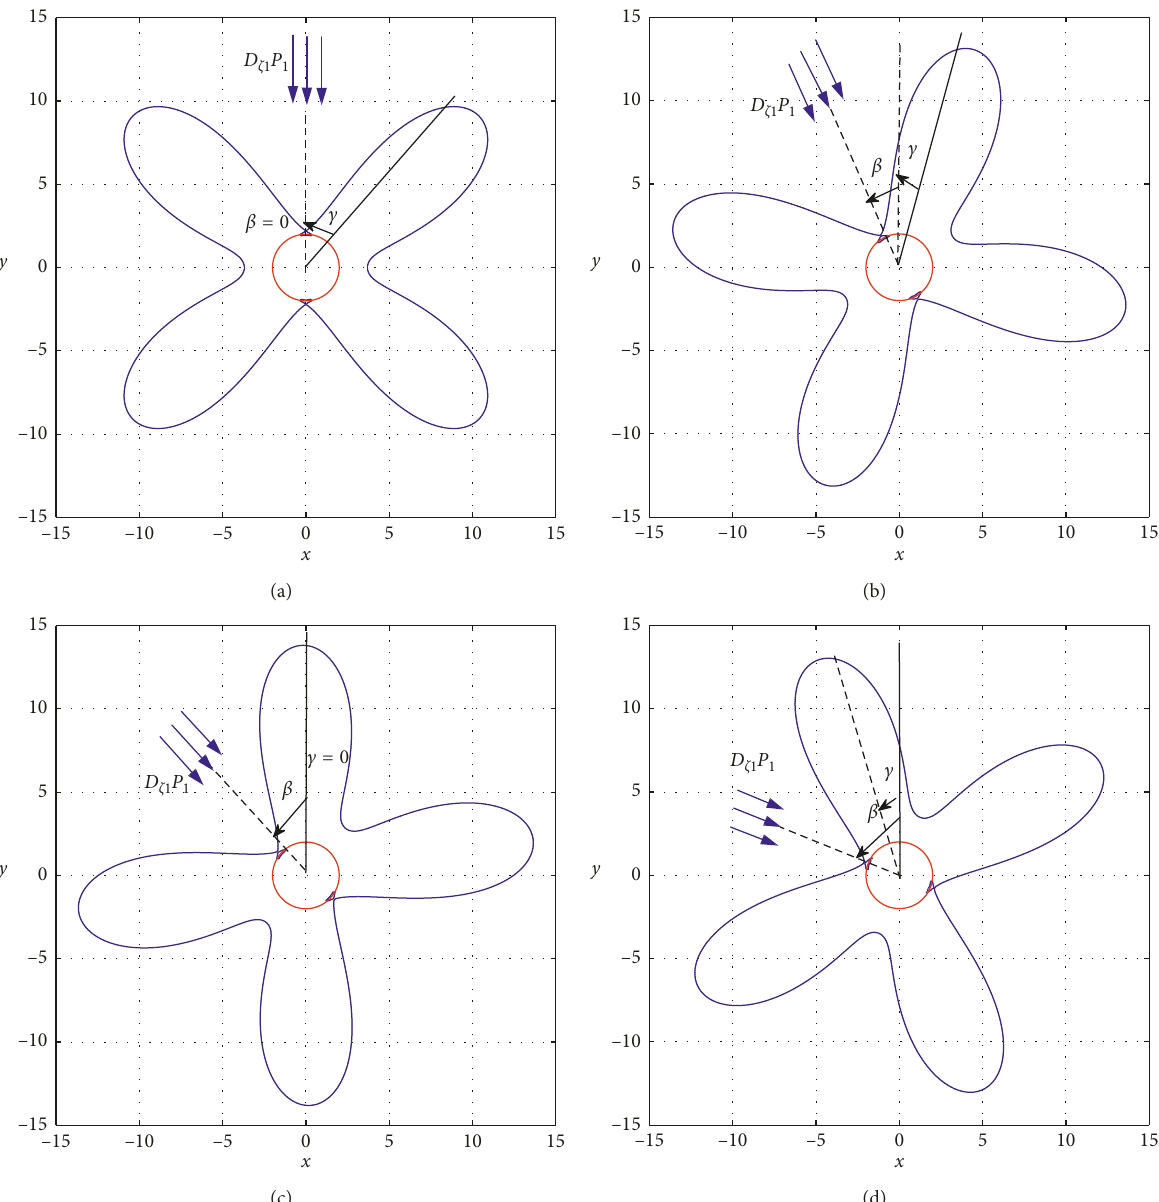
Figure 6: Distribution of the plastic zone around the circular roadway under deflection of the principal stress field: (a) β 70 ° (c) β 50 ° ; (d) β (cid:31) (cid:31)